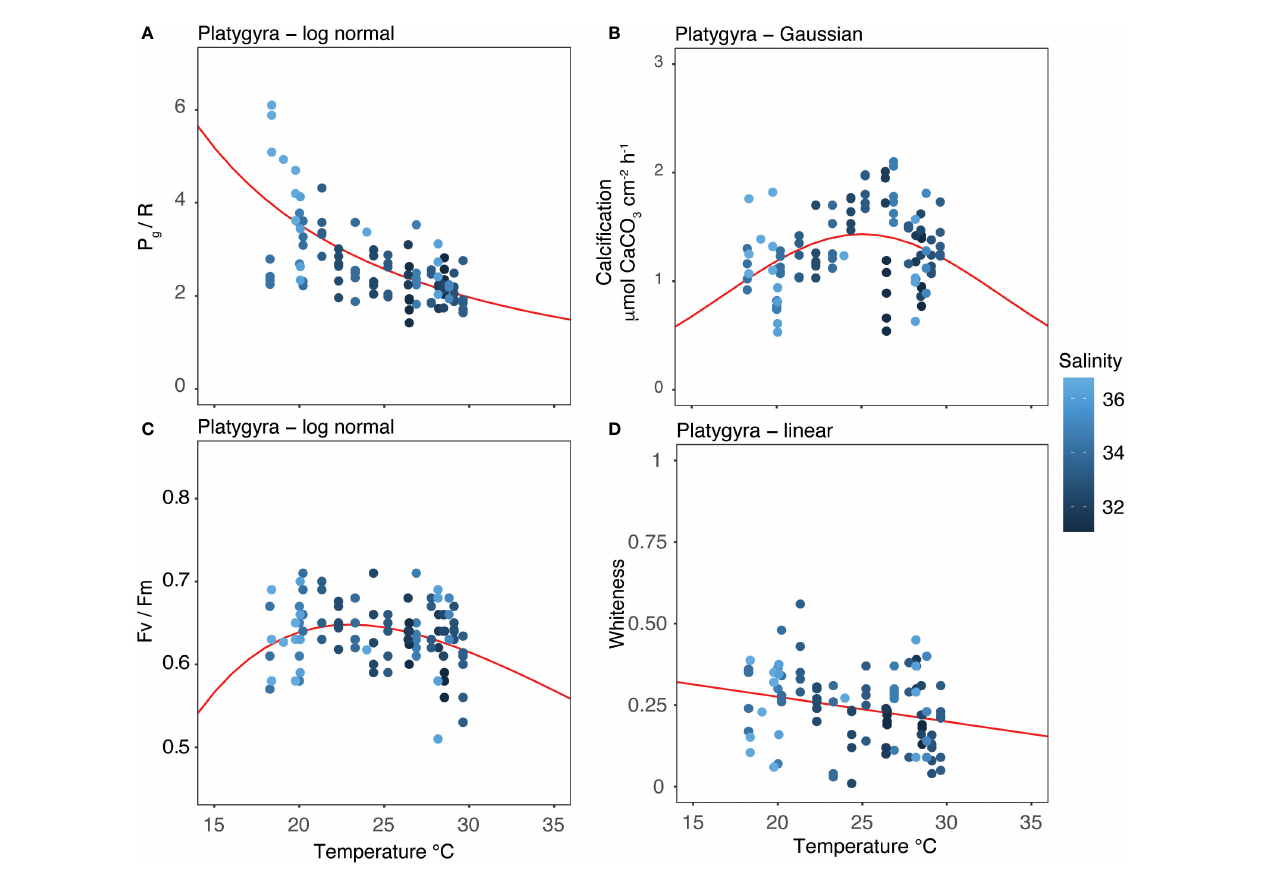
FIGURE 6 Thermal performance curves of each coral metabolic parameters: (A) P g /R; (B) calci fi cation; (C) Fv/Fm; and (D) whiteness. Points show descrete measurements collected every month between April 2018 and March 2020. Lines show the best- fi tting models as determined by Akaike Information Criterion (AICc). The color gradient of the points represents the salinity level at the time of data